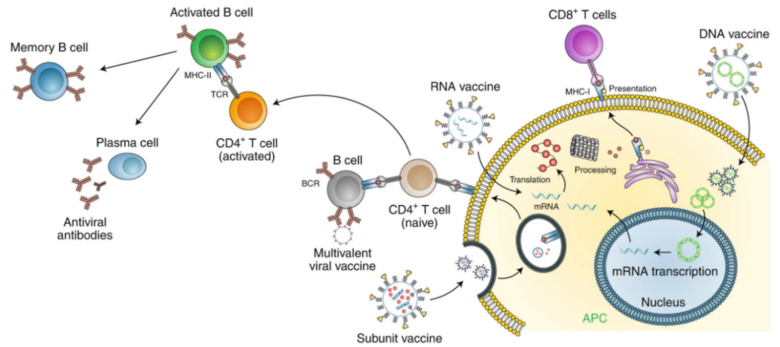
Figure 2. The application of nanoparticle for disease prevention. Lipid nanoparticles are used in nucleic acid-based vaccines. For instance, it has been used in mRNA vaccine development for COVID- 19. They act as a carrier to introduce mRNA into host cells and protect mRNA from degradation. Adapted with permission from reference [59] © Springer Nature